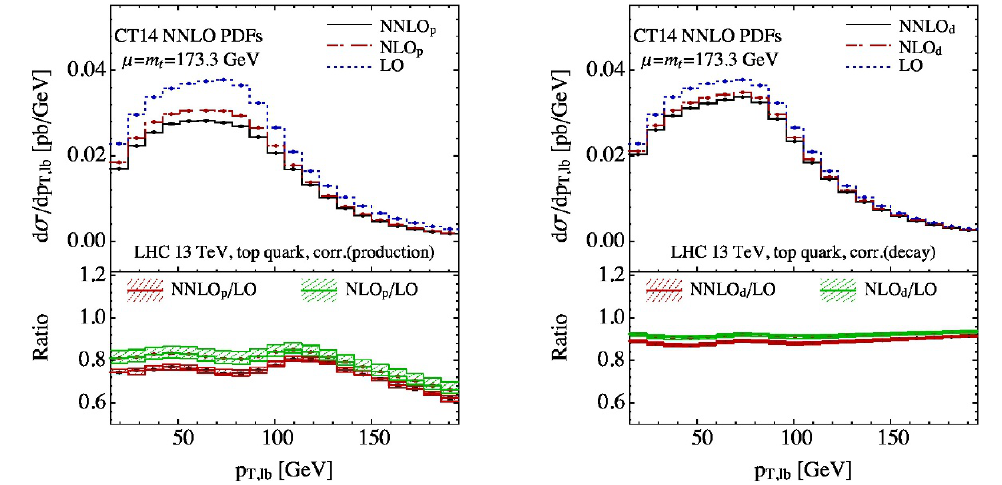
Figure 28 . Predicted transverse momentum distribution of the charged lepton and b -jet system from t -channel single top-quark production at 13 TeV after (cid:12)ducial cuts, including corrections from production and decay